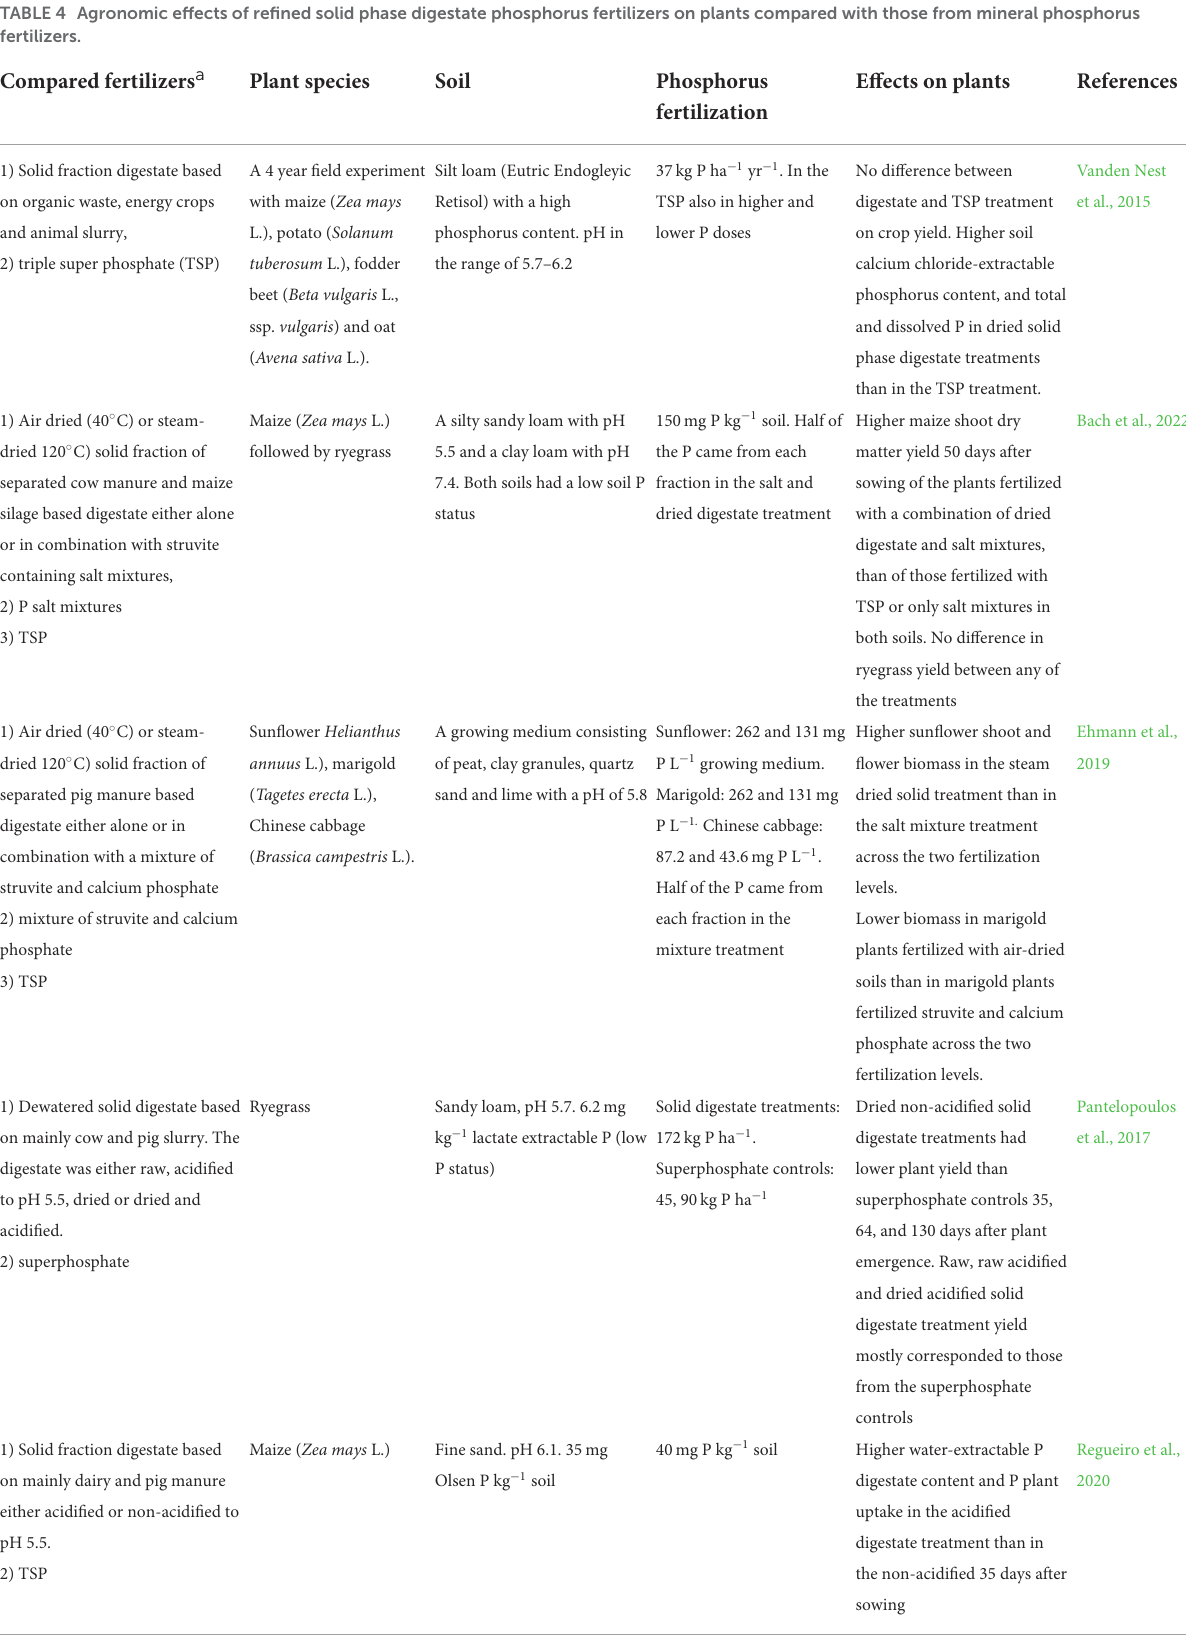
TABLE 4 Agronomic effects of refined solid phase digestate phosphorus fertilizers on plants compared with those from mineral phosphorus fertilizers. Compared fertilizers